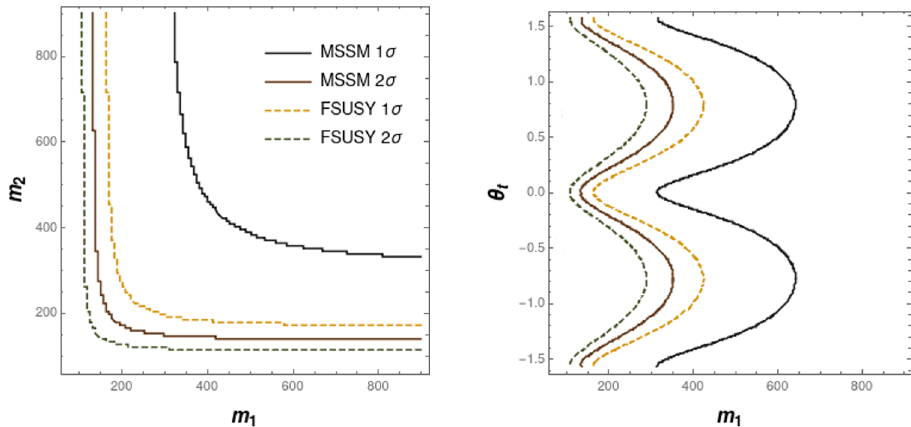
Figure 5 . Exclusion bounds in stop parameter space due to h → γγ and gluon fusion measurements: the solid rust (black) lines represent the 2 (1) sigma exclusion bounds for stops and the dashed green (yellow) lines represent the 2 (1) sigma exclusion bounds for F-stops. The left figure is in the stop mass 1, stop mass 2 plane with zero mixing. The right figure is in the stop mass 1, stop mixing angle plane, with stop mass 2 held at 1